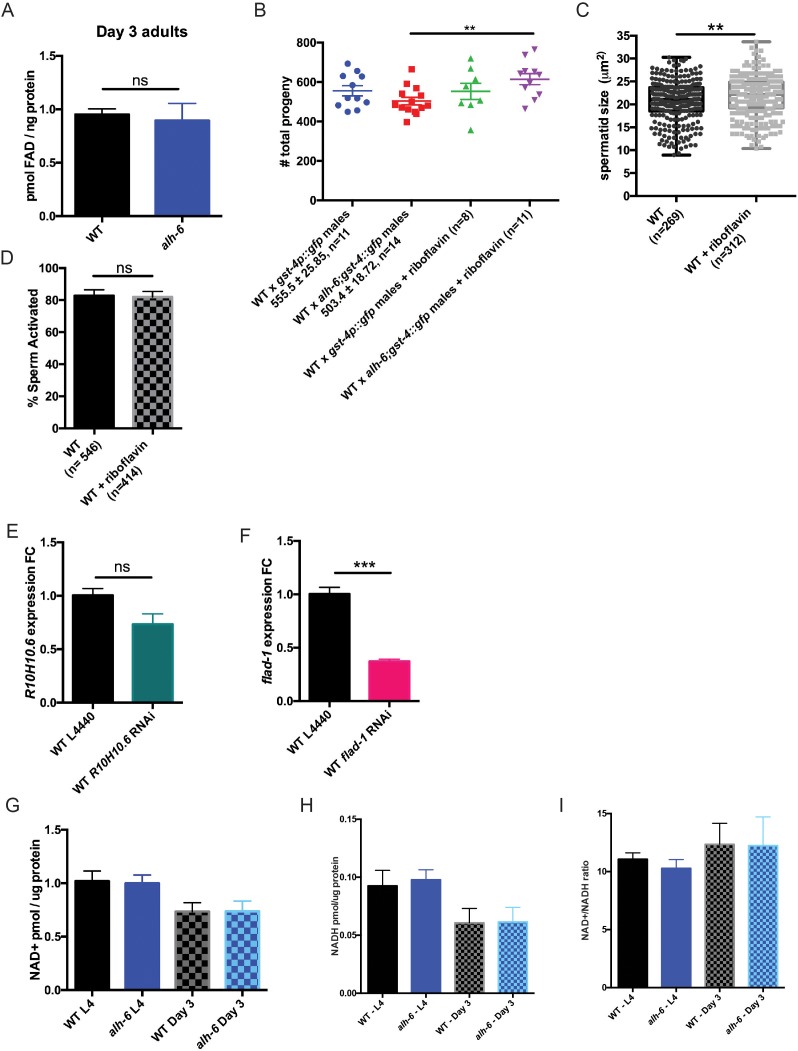
Adenine nucleotide cofactor homeostasis is disrupted in alh-6 mutants.(A) FAD levels are unchanged between WT and alh-6 mutant animals fed OP50 at day three adulthood. (B) WT hermaphrodites mated to alh-6;gst-4p::gfp males fed OP50 supplemented with 2.5 mM riboflavin results in increase in total brood size compared to WT hermaphrodites mated to non-supplemented alh-6;gst-4p::gfp males. (C) Dietary riboflavin supplement increased spermatid size of WT males. (D) WT males fed OP50 diet supplemented with riboflavin have similar % spermatid activated upon Pronase treatment as those without riboflavin supplement. (E) R10H10.6 one expression is modestly reduced by whole animal RNAi via RT-PCR verification. (F) flad-1 expression is reduced by whole animal RNAi via RT-PCR verification. (G) NAD levels are unchanged between WT and alh-6 animals at L4 and day three adulthood (H) NADH level is unchanged between aged matched WT and alh-6 hermaphrodites at both L4 and Day three adulthood. (I) NAD+/NADH level is unchanged between aged matched WT and alh-6 hermaphrodites at both L4 and Day three adulthood. *, p<0.05; **, p<0.01; ***, p<0.001; ****, p<0.0001. Statistical comparisons done by unpaired t-test for all experiments except for sperm activation, which is done by Fischer’s exact test. All studies performed in biological triplicate; refer to Supplementary file 1 for n for each comparison.